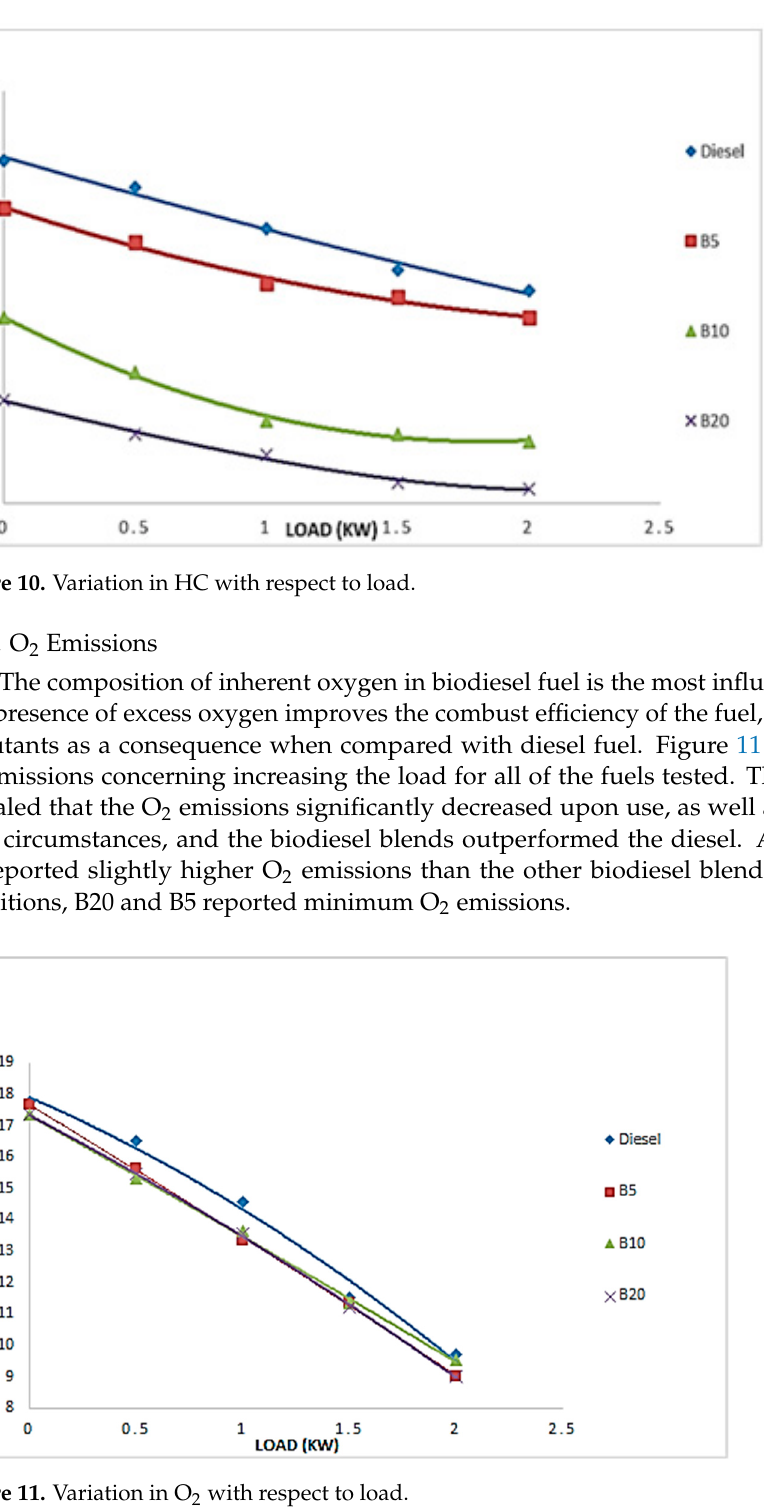
2 with respect to